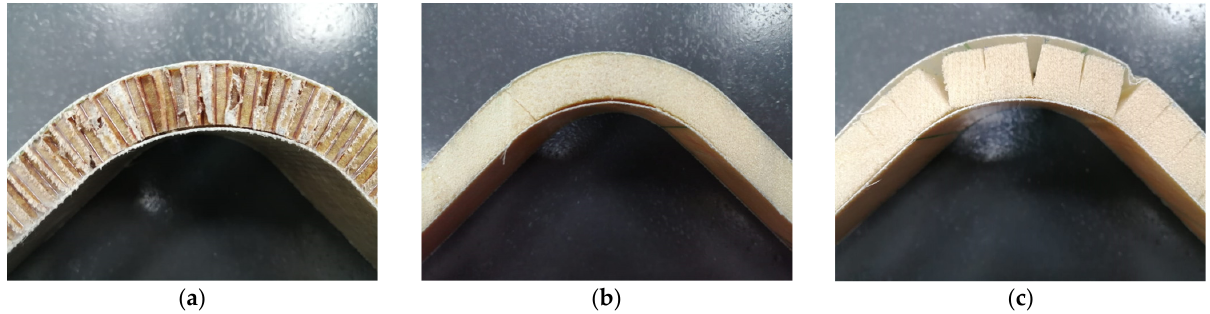
Figure 9. Pictures corresponding to the V ‐ shaped panels after bending tests of ( a ) GF/HC/GF, ( b ) GF/Foam/GF, and ( c ) GF/griding foam/GF. Table 2. Bending parameters.